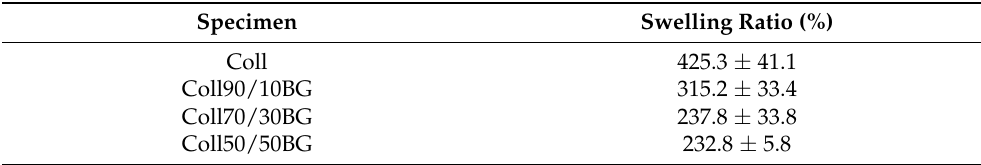
Table 5. Swelling ratio of collagen materials with β -glucan addition.